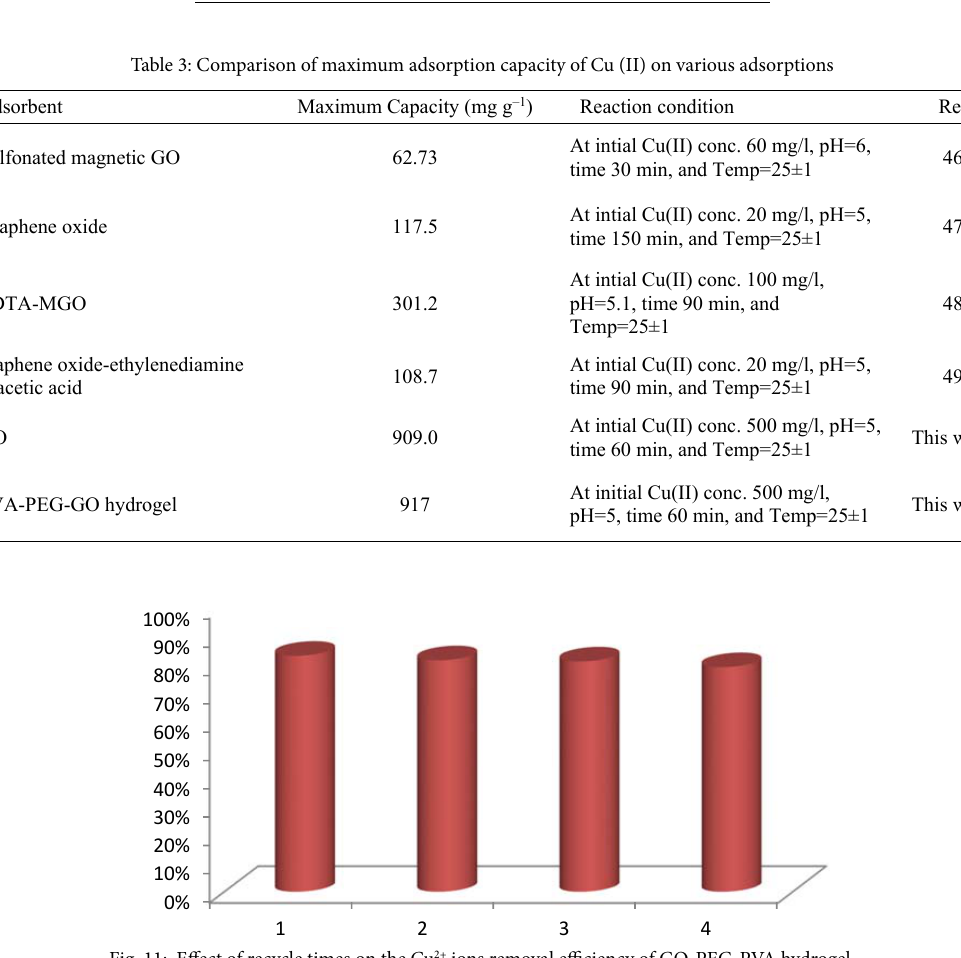
Fig. 11: Effect of recycle times on the Cu 2+ ions removal efficiency of GO-PEG-PVA